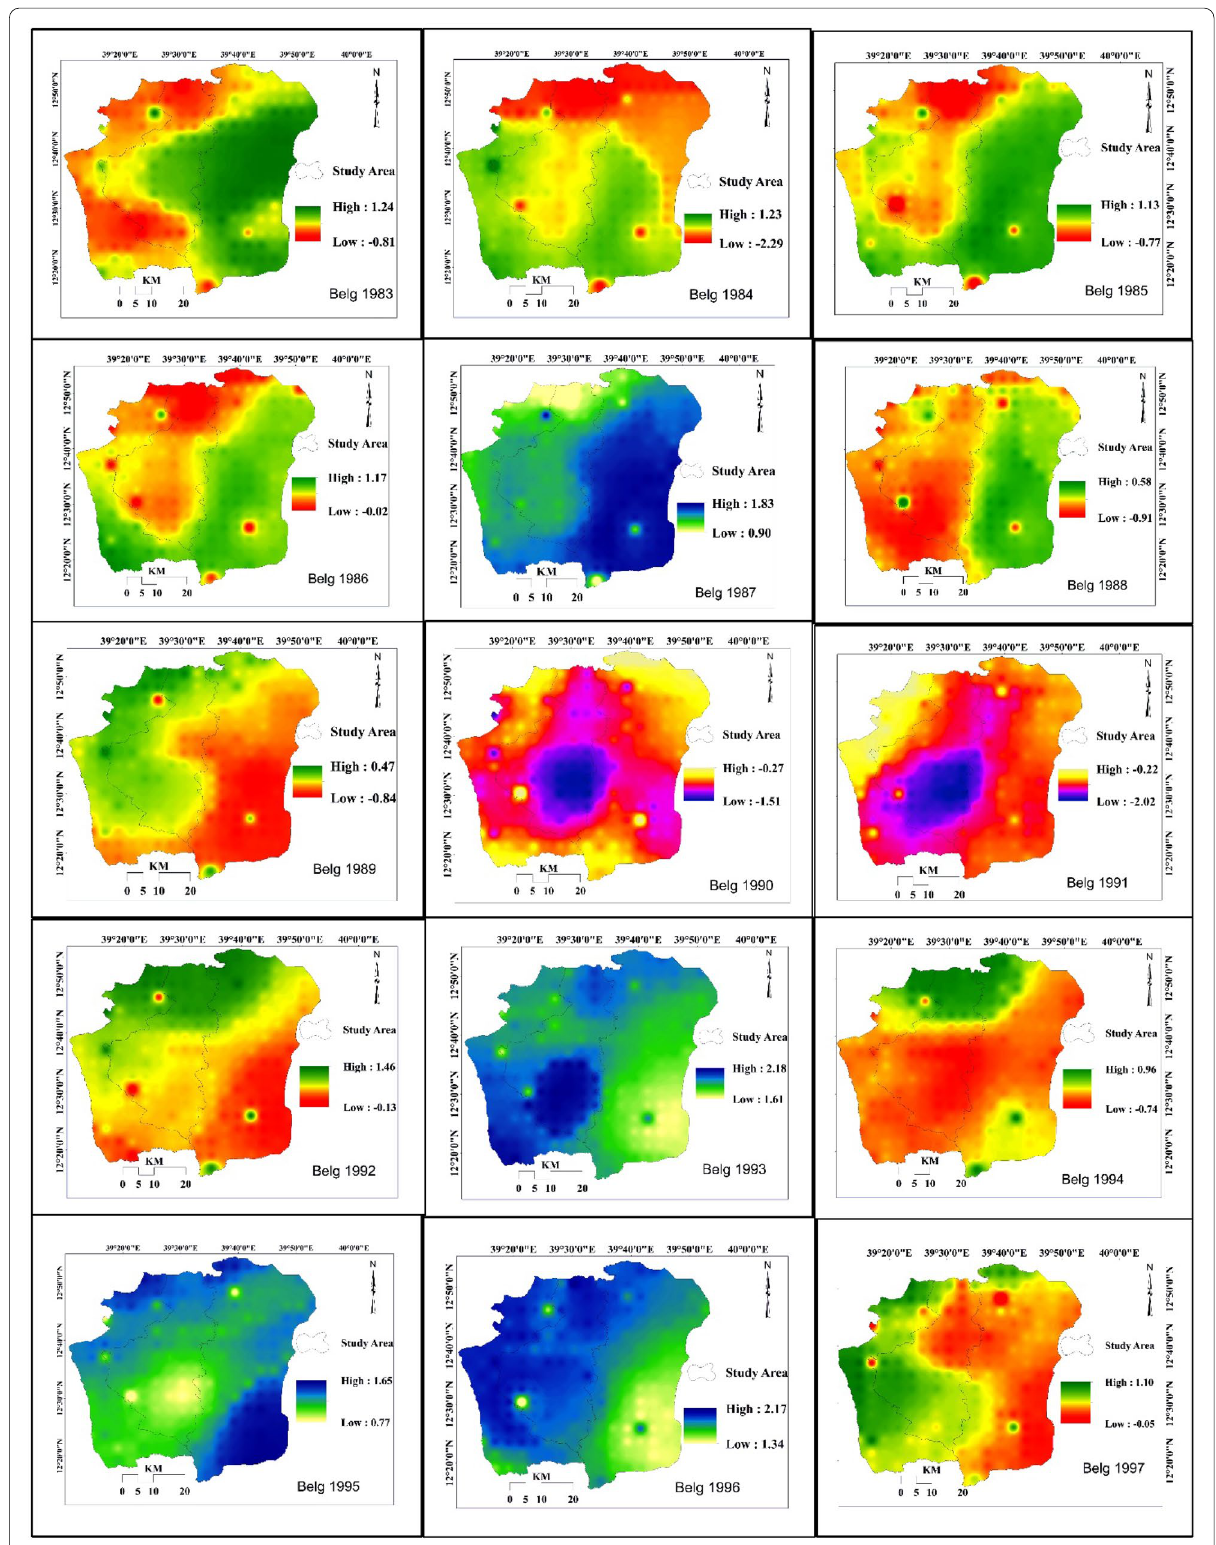
Fig. 3 Map of spatial drought trends in Belg seasons from